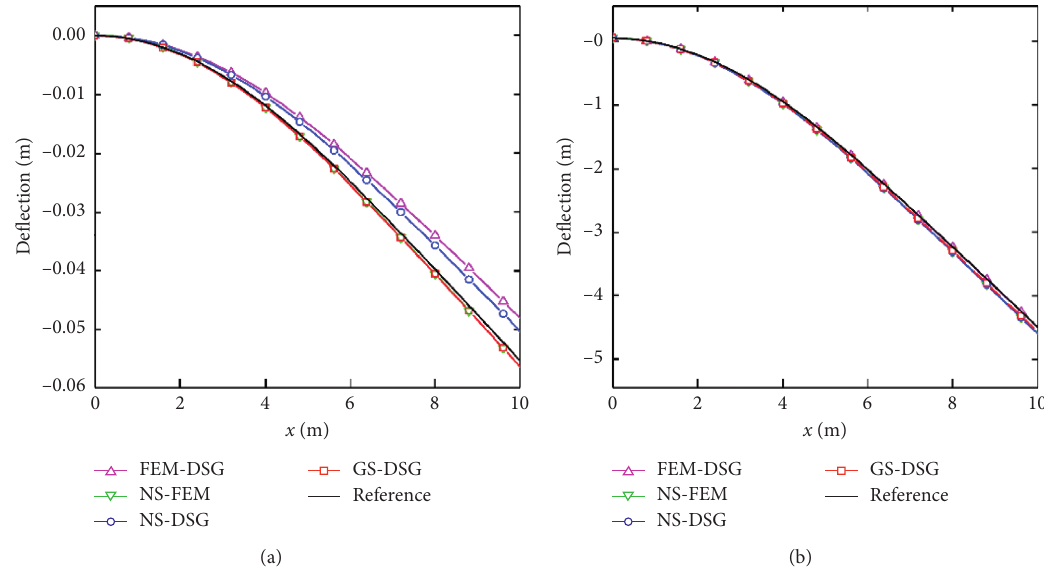
Figure 8: Deflections along the line OA with different thickness (uniformly distributed load): (a) t � 0 . 01; (b) t � 0 .